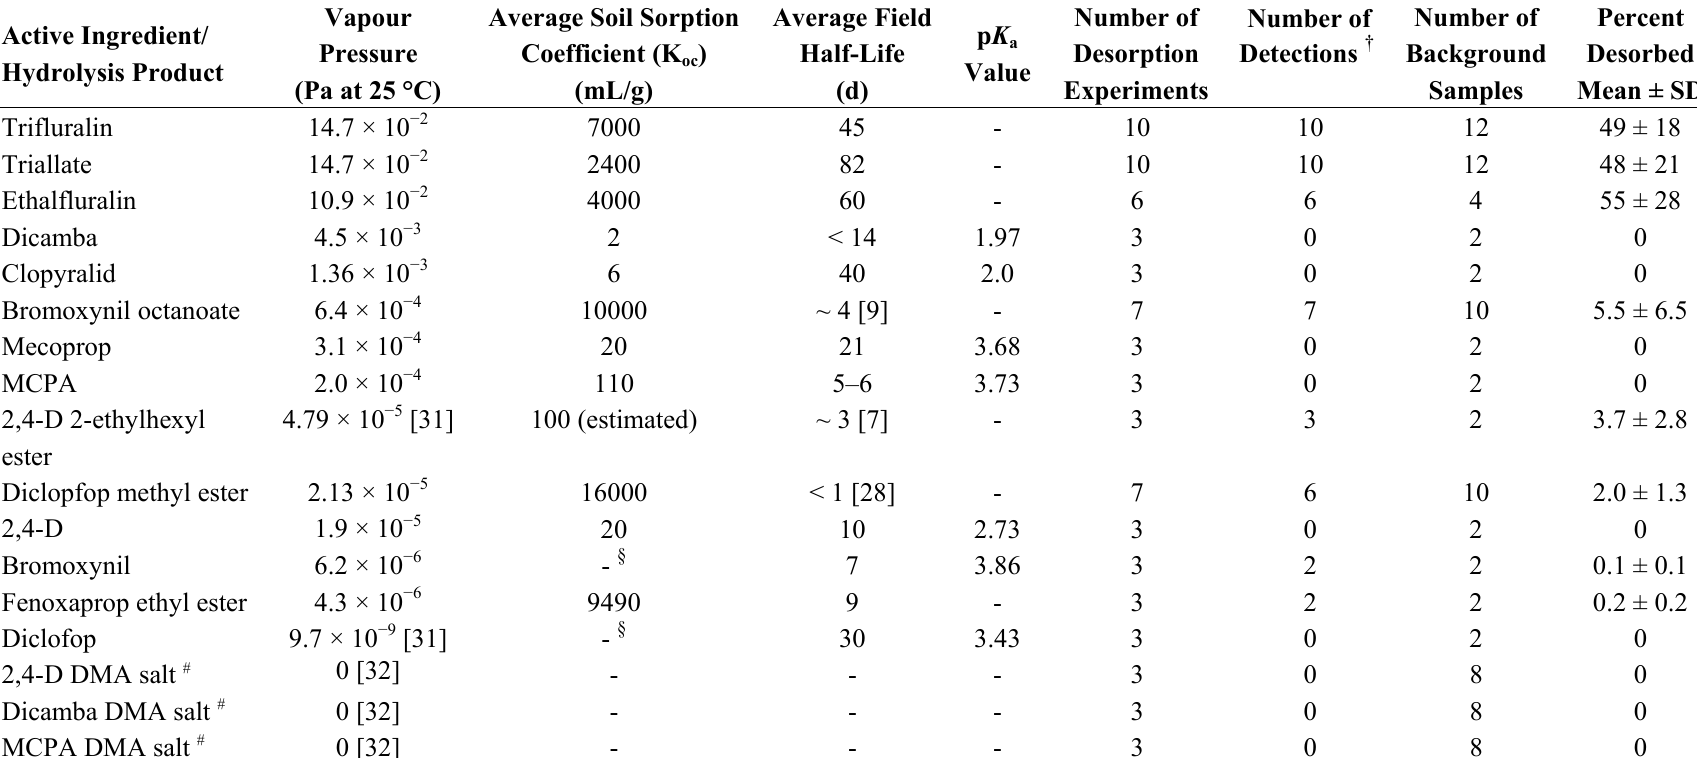
Table 3. Characteristics * of each active ingredient/hydrolysis product and, in the order of decreasing vapour pressure, the percent of each analyte captured on the PUF/XAD-2 composite resin cartridge during the desorption